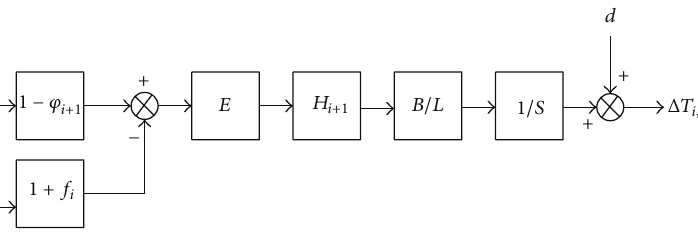
Figure 3: Block diagram of tension system between adjacent stands.